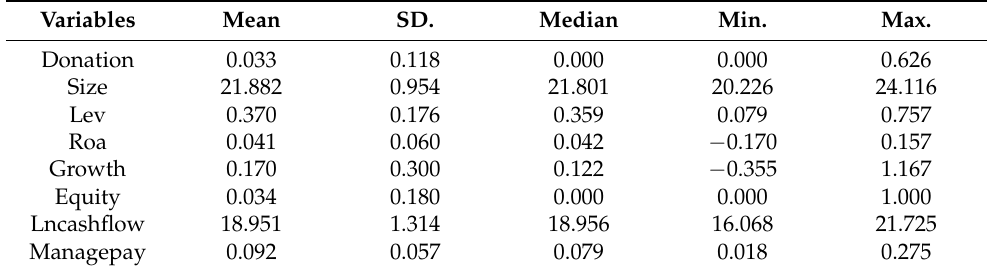
Table 3. Descriptive statistics of the main variables.